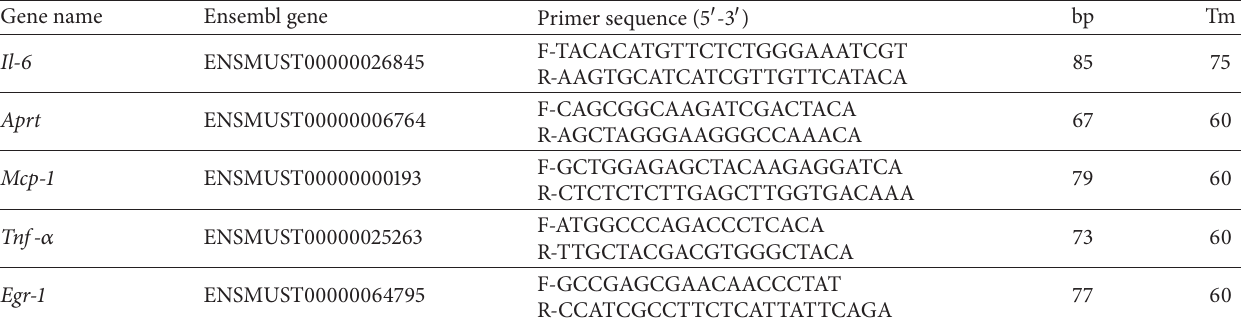
Table 1: Primer sequences used for real-time quantitative